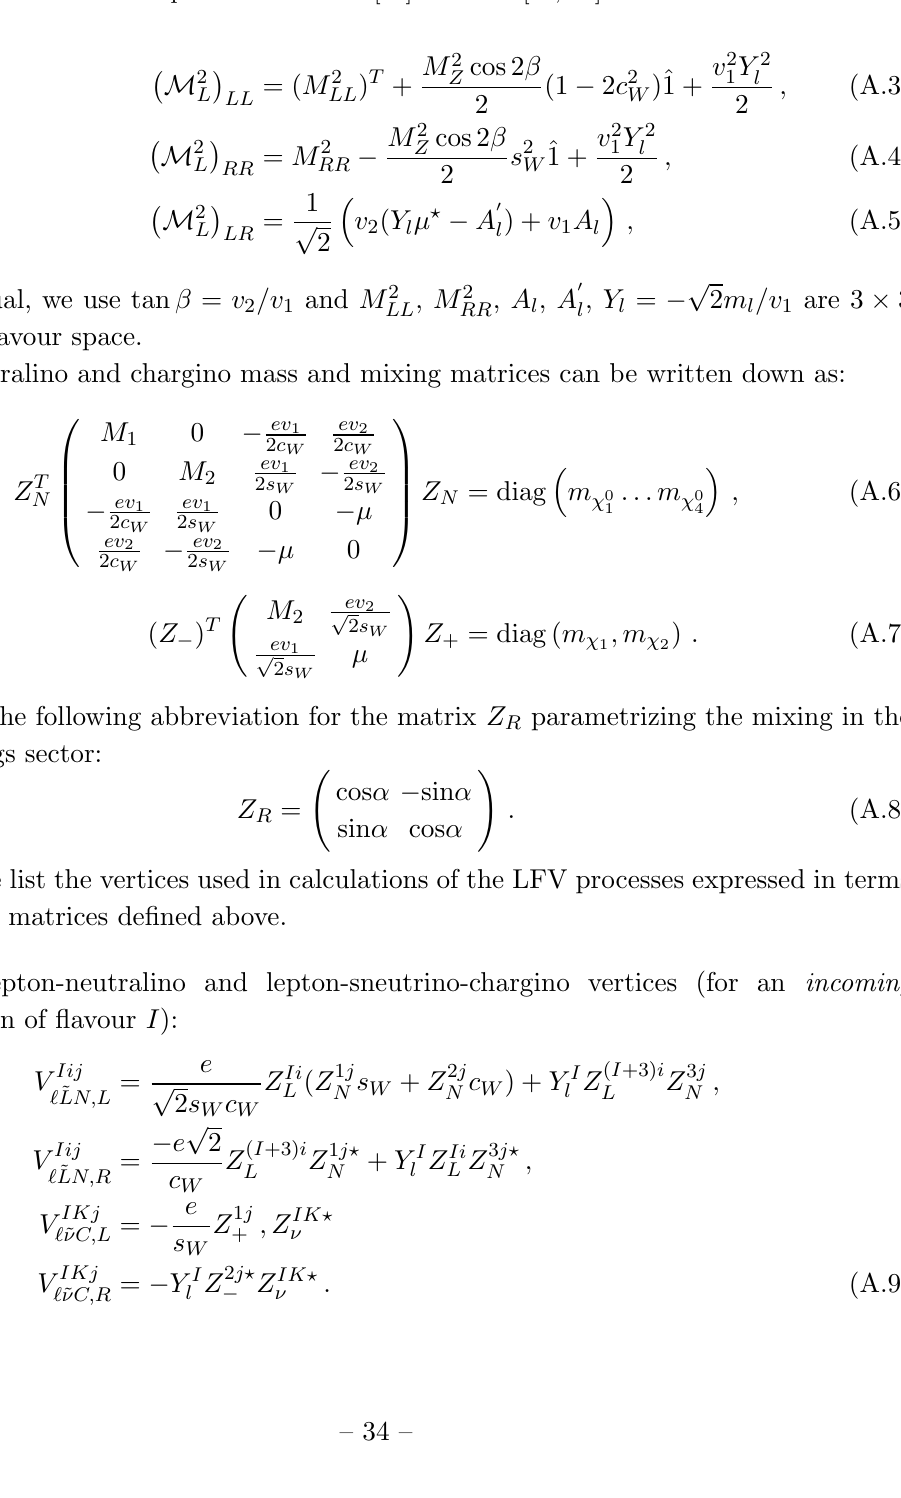
Table 6 . Comparison of SLHA2 [45] and refs. [43, 44]